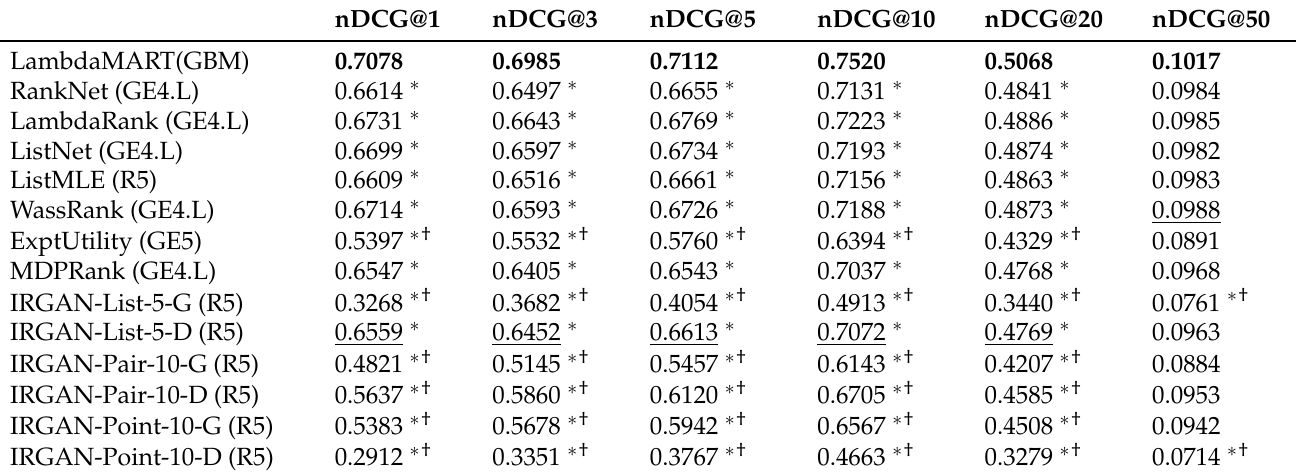
Table 3. The performance of involved approaches in Set1.